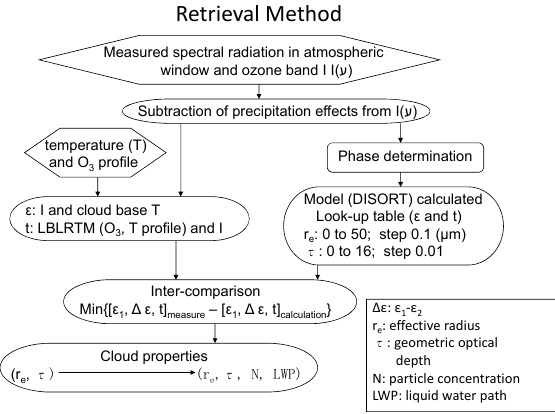
Fig. 1. Diagram illustrating the cloud property retrieval method. The parameters r e , τ , ε , t , N and WP represent effective radius, visible optical depth, cloud emissivity, cloud transmittance, particle con- centration and water path, respectively. Cloud phase is determined first based on cloud spectral emissivity and cloud base brightness temperature. A look-up table including ε and t for a range of r e and τ is computed with DISORT for the corresponding phase. Calcu- lated ε and t are obtained based on measurements. A minimisation of the difference between calculated ε and t and values in the look- up table is used to obtain r e and τ . Cloud N and WP are obtained based on a log-normal size distribution and the retrieved values of r e and τ